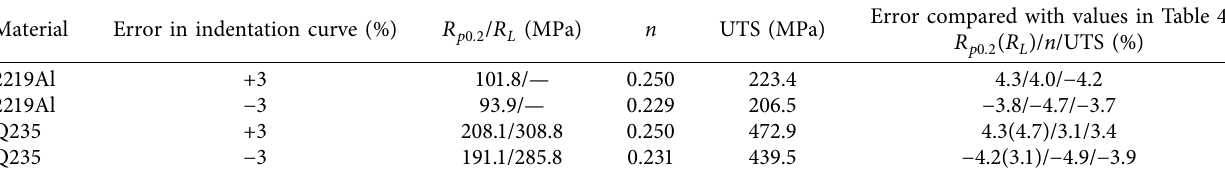
Table 6: Plastic properties obtained from the indentation curves with 3% error.